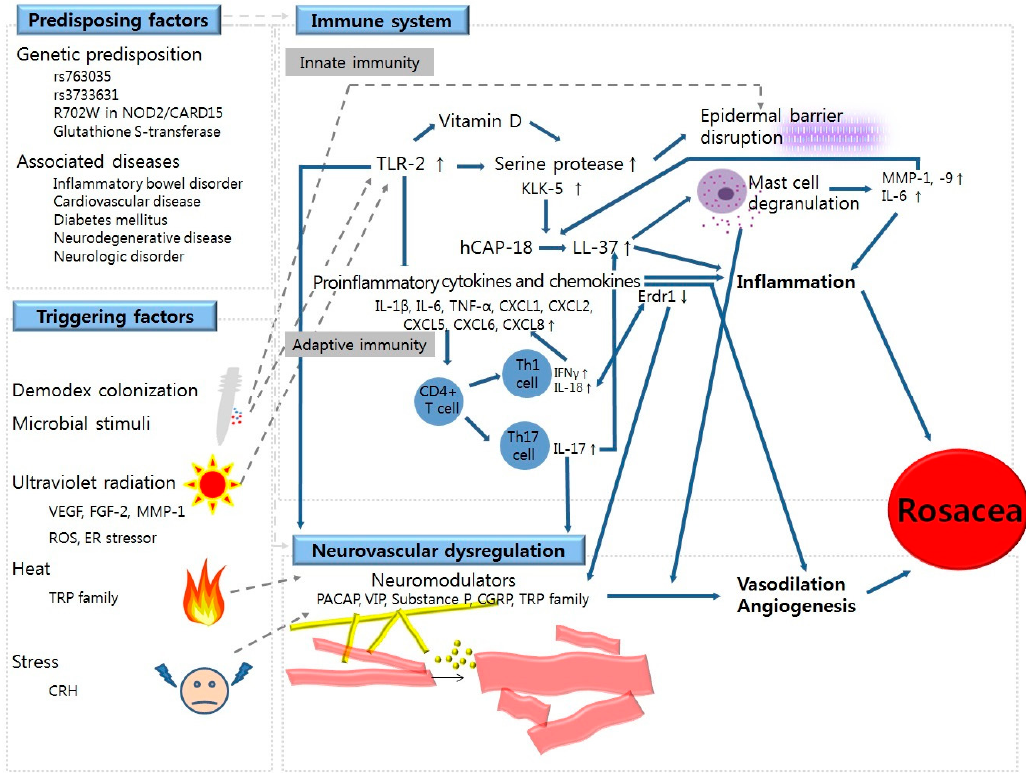
Figure 3. Representation of proposed mechanisms for rosacea. Predisposing factors are associated with dysregulated immune responses and neurovascular dysregulation. Among the triggering factors, demodex proliferation directly disrupts the epidermal barrier. Demodex and ultraviolet radiation can cause the elevated expression of TLR-2. TLR-2 regulates the release of KLK-5, which disrupts the epidermal barrier and activates the cleavage of hCAP-18 into LL-37. LL-37 stimulates tissue inflammation, vasodilation, and angiogenesis in rosacea. LL-37 also facilitates the degranulation of mast cells, which further enhances the expression of MMP-1, MMP-9, and IL-6. Furthermore, Th1 and Th17-mediated immune reactions affect inflammation in rosacea. In addition, Erdr1 is related to the upregulation of IL-18 and angiogenesis. Heat and stress can induce the release of various neuromodulators, such as PACAP, VIP, substance P, CGRP, and the TRP family. These cause neurovascular dysregulation, which consequently results in inflammation, vasodilation, and angiogenesis in rosacea. Blue solid lines indicate pathophysiological pathways involved in rosacea. Dashed lines denote the proposed mechanisms for triggering factors and predisposing factors in rosacea. Upward arrows indicate increased expression of certain protein. Abbreviation: TLR, Toll-like receptor; KLK-5, Kallikrein-5; MMP, Matrix metalloproteinase; PACAP, Pituitary adenylate cyclase-activating polypeptide; VIP, Vasoactive intestinal peptide; CGRP, Calcitonin gene-related peptide; TRP, Transient receptor potential, VEGF, Vascular endothelial growth factor; FGF, Fibroblast growth factor; ROS, Reactive oxygen species.